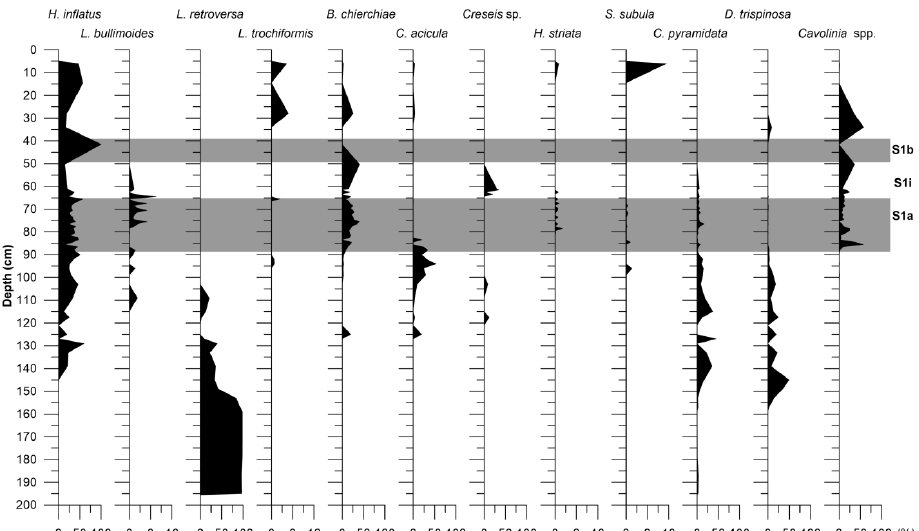
Figure 4 . Frequency curves of the most indicative pteropods in core KIM-2A. Gray bands represent the sapropel S1 sublayers. X axes scales are of 100% and 16% corresponding to the high and low frequency abundances respectively.